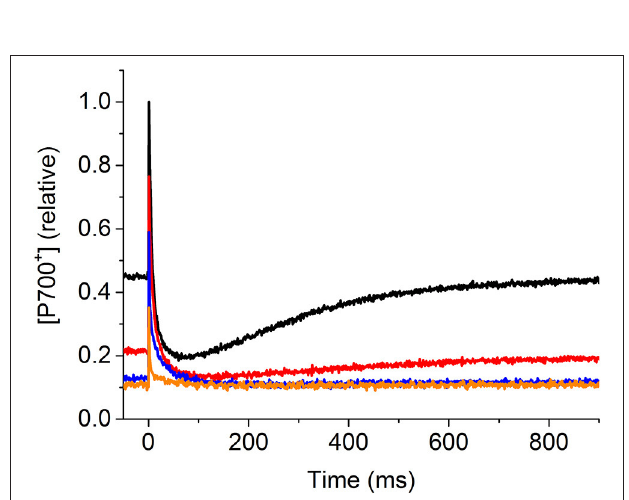
FIGURE 4 | Relative changes in P700 kinetics signals in the coral P. decussata over the course of heat treatment and recovery period, in the presence of DCMU. P m (A) , and initial steady-state level of P700 + (B) were recorded on the same dark-adapted samples, at the same time point. Control, black column; heat treatment, red column and recovery, blue column. Gray bars show the signal in the absence of DCMU, normalized to 1, to show relative changes caused by the treatments. Signals were recorded on the same samples under the same temperature treatment as described for Figure. Statistically significant differences between − DCMU and + DCMU control samples ( p < 0.05) are shown with asterisk. Error bars are standard errors of mean (SEM), n = 3.